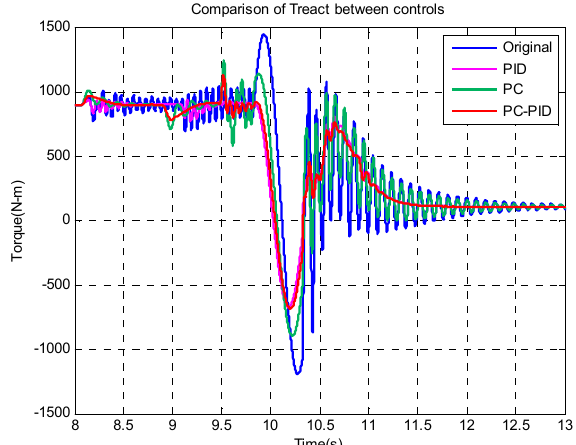
Figure 8. Vehicle half-shaft torque during acceleration in time domain.